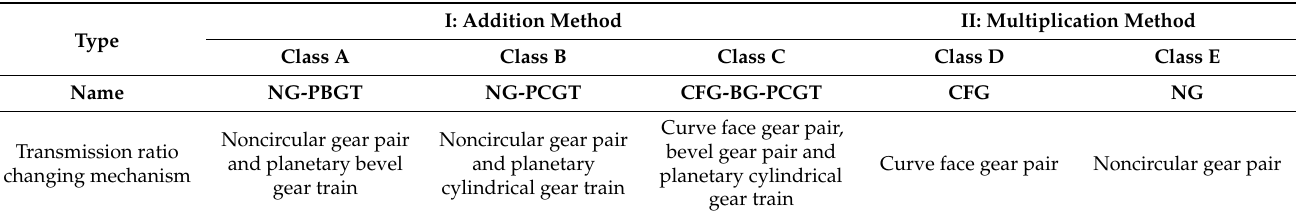
Table 1. CVT pattern of spatial noncircular gear.